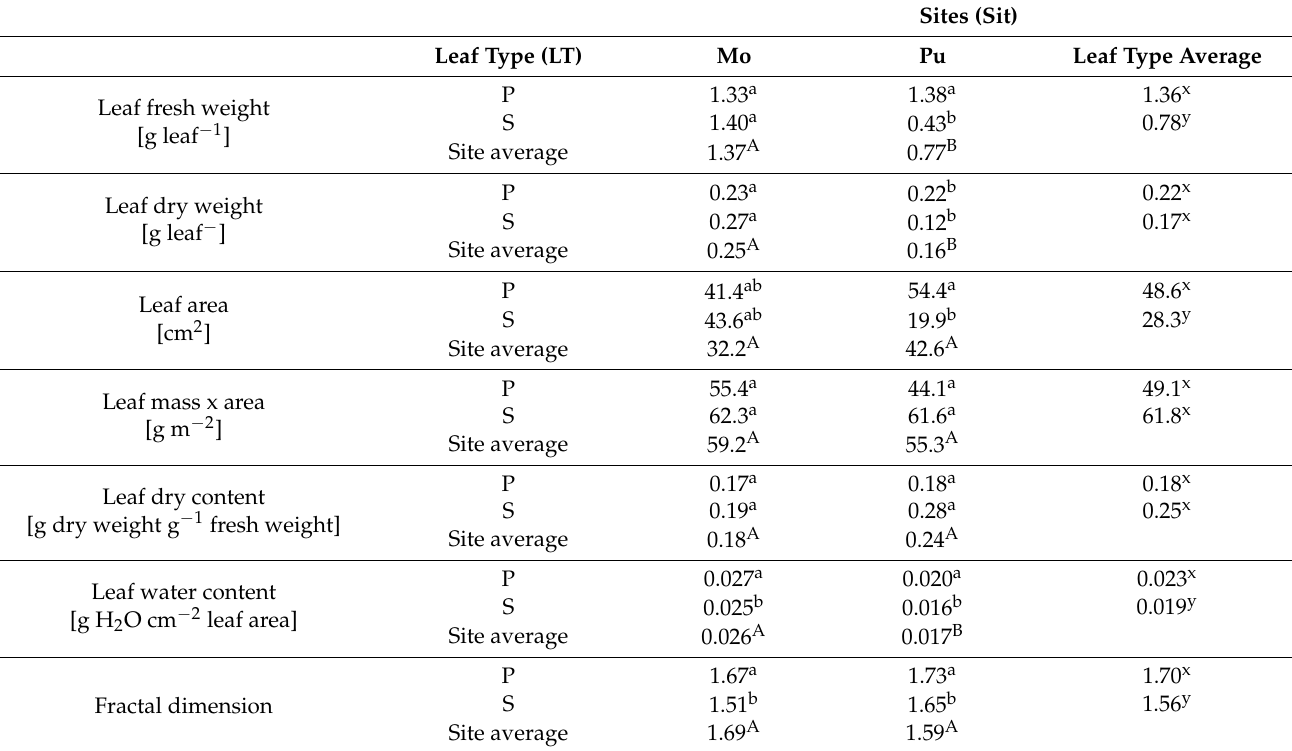
Table 4. Biometric and morphological parameters of different leaf types (P: petiolate; S: sessile) of Salvia ceratophylloides individuals of two sites (Mosorrofa, Mo; Puzzi, Pu). Different lower-case letters indicated significant differences at p < 0.05 among the average within the column (Tukey’s test). Different capital case letters indicated statistically significant differences among the means along the rows ( p < 0.05, Tukey’s